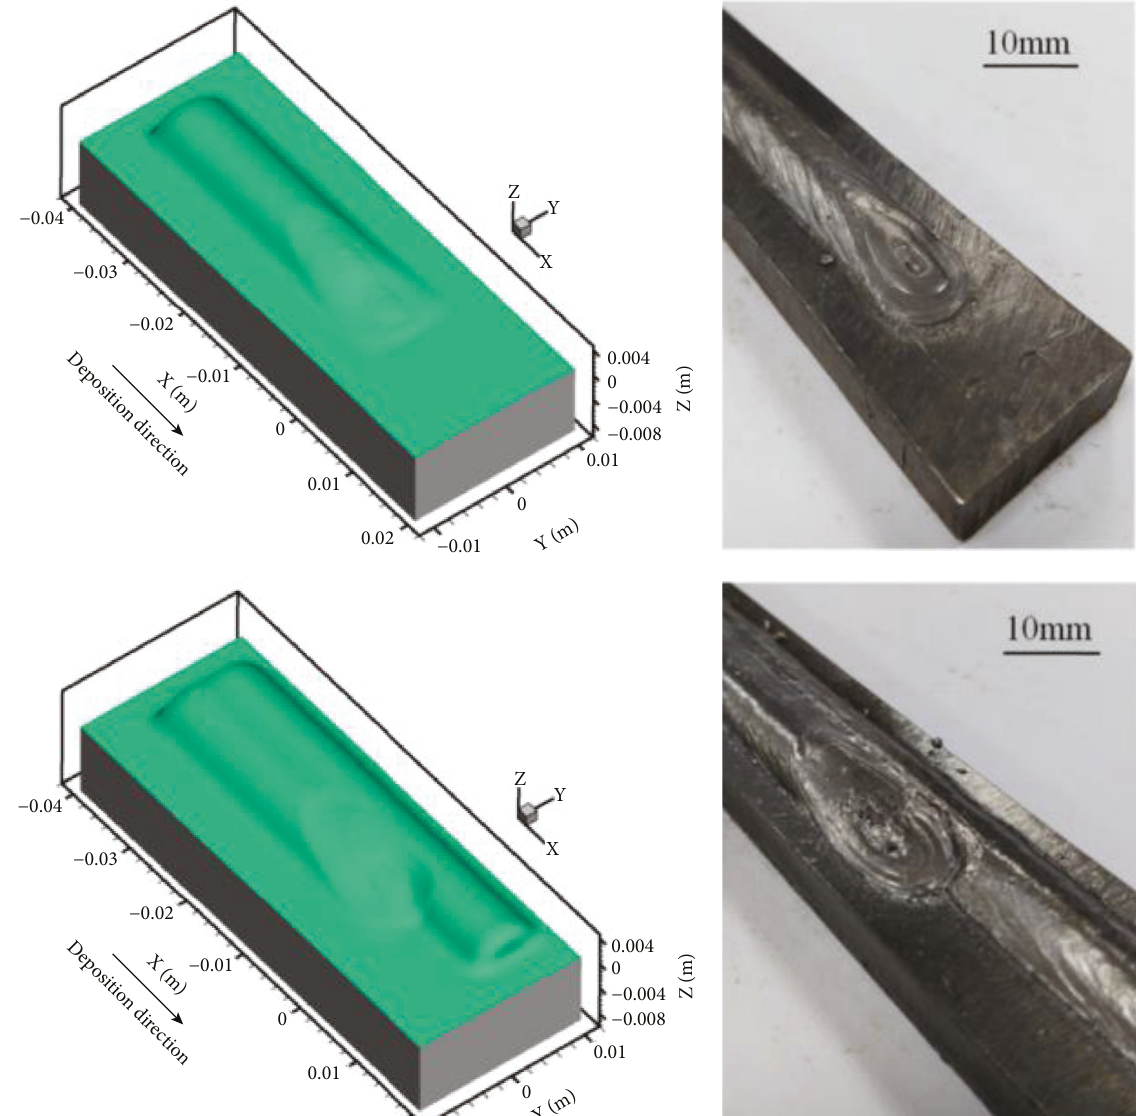
Figure 15: Molten pool morphology of single-bead and overlapping